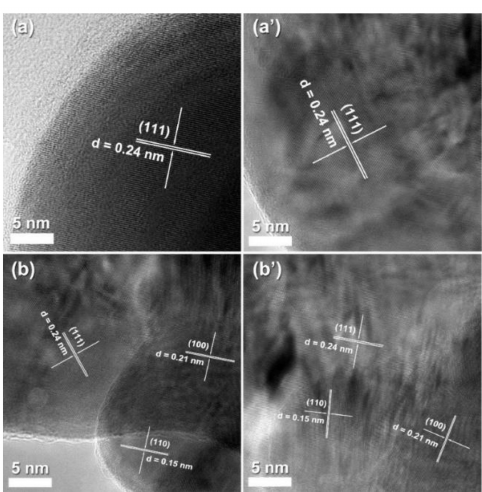
Figure 3. HR-TEM images of Ag foam ( a ), Ag foam -after reaction ( a’ ), pristine Ag ( b ) and pristine Ag -after reaction ( b’ ).